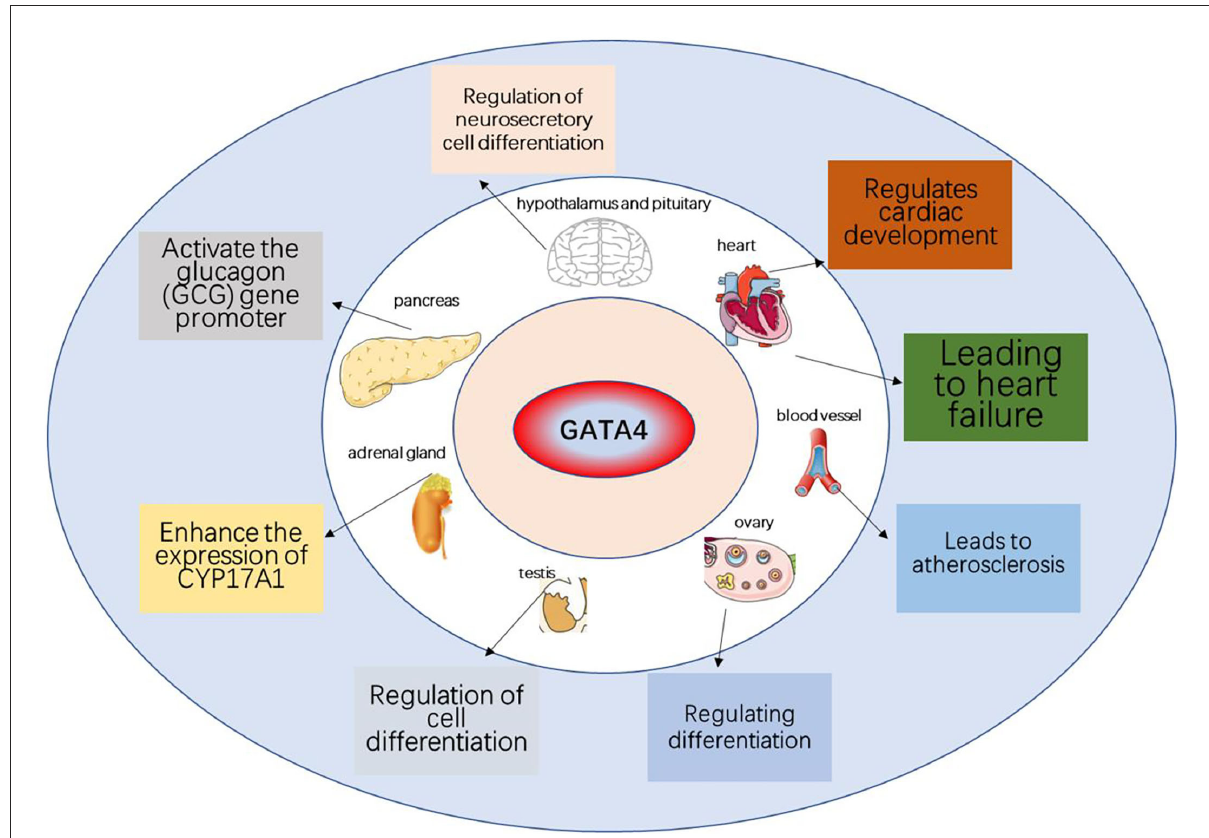
FIGURE2 The process of DNA damage leading to cell senescence and the role of GATA4 in it. DNA damage signals activate ATM and ATR, causing the p53 and p16 pathways to activate, blocking cell cycles and, in turn, aging cells. ATM and ATR can also suppress selective autophagy between p62 and GATA4, activating NF- κ B and SASP.